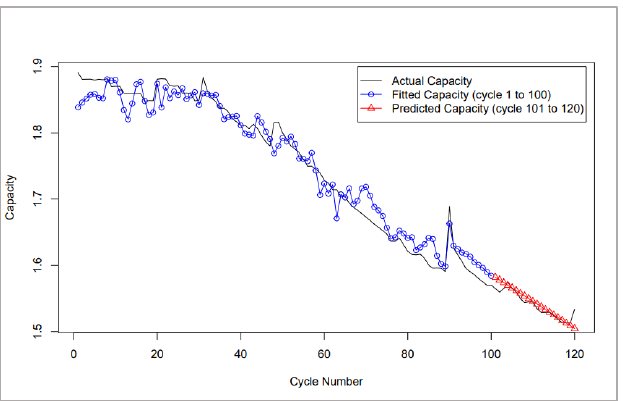
Figure 6. Capacity prediction results of Case 1. The errors, such as root mean square error (RMSE) and mean absolute percentage